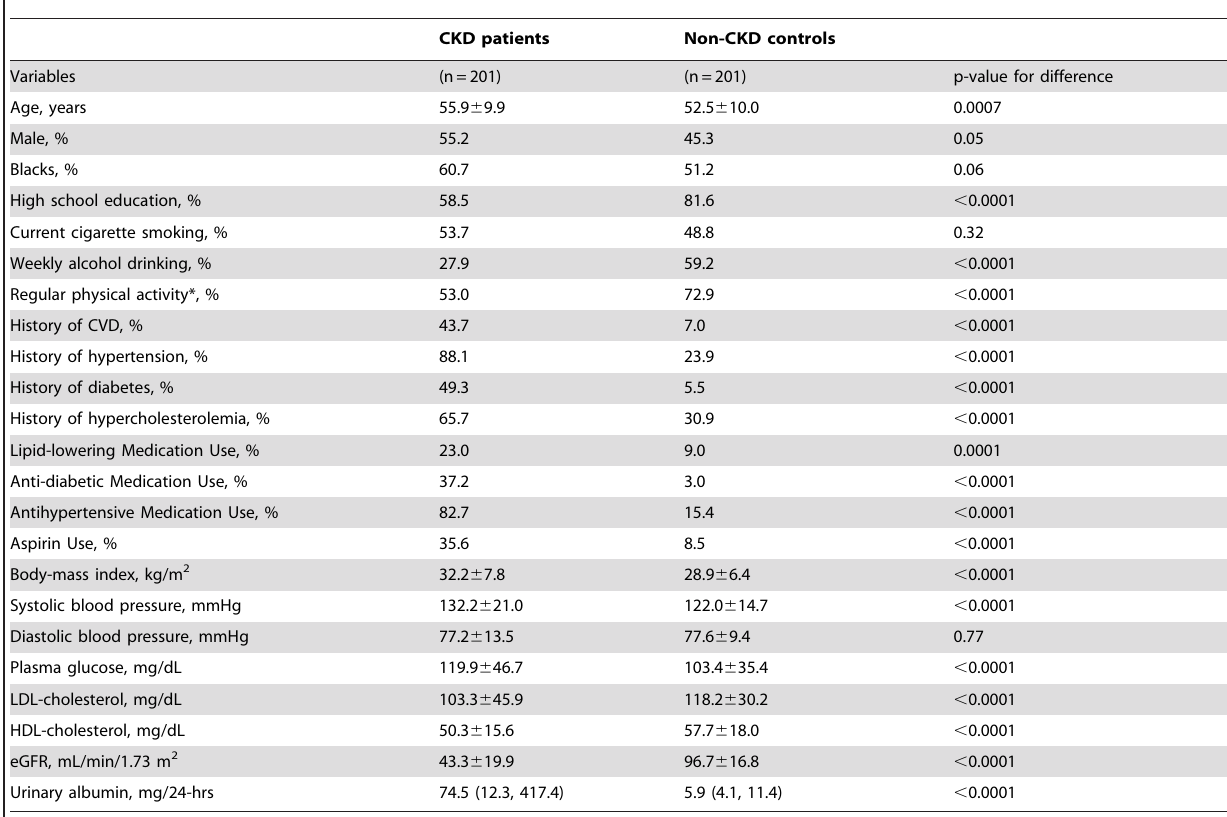
Table 1. Characteristics of 201 patients with chronic kidney disease and 201 controls.